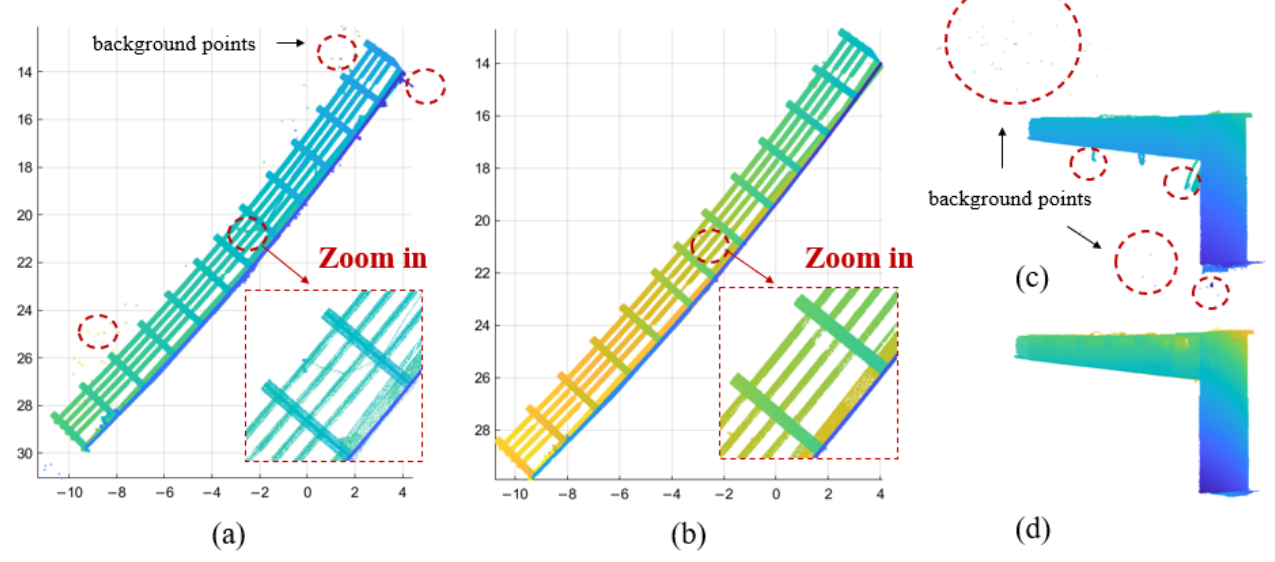
Figure 12. Experimental process for background points: top view of the scanned data of SBGs ( a ) before and ( b ) after applying the DBSCAN algorithm; side view of the scanned data of SBGs ( c ) before and ( d ) after applying the DBSCAN algorithm.